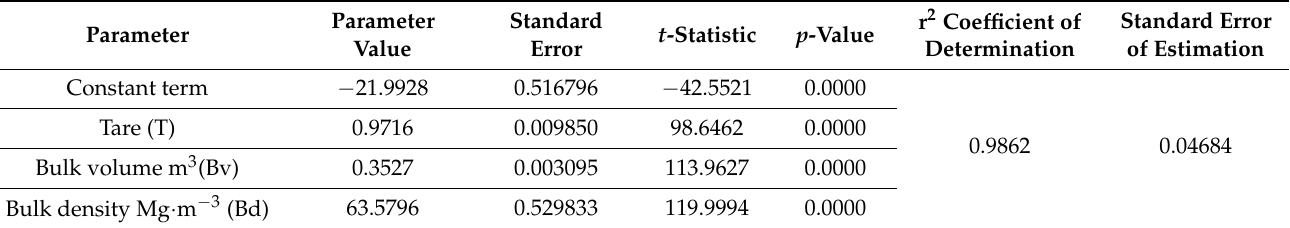
Table 4. Evaluation of model parameters on GVW for wood chips transport.